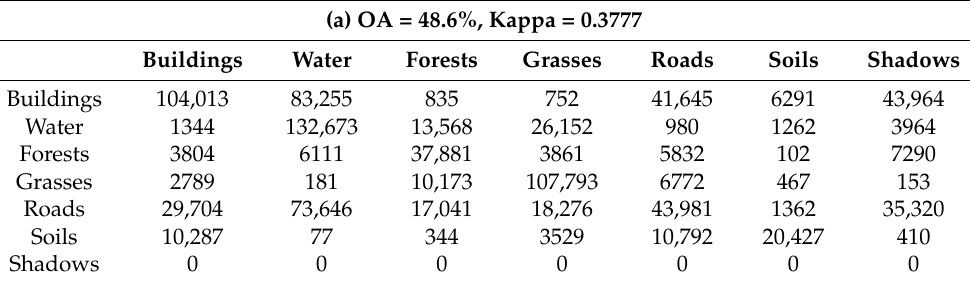
Figure 10. Classification maps of different methods in the test regions. Table 7. Confusion matrixes of (a) CI, (b) SR, (c) AS, and (d) the proposed